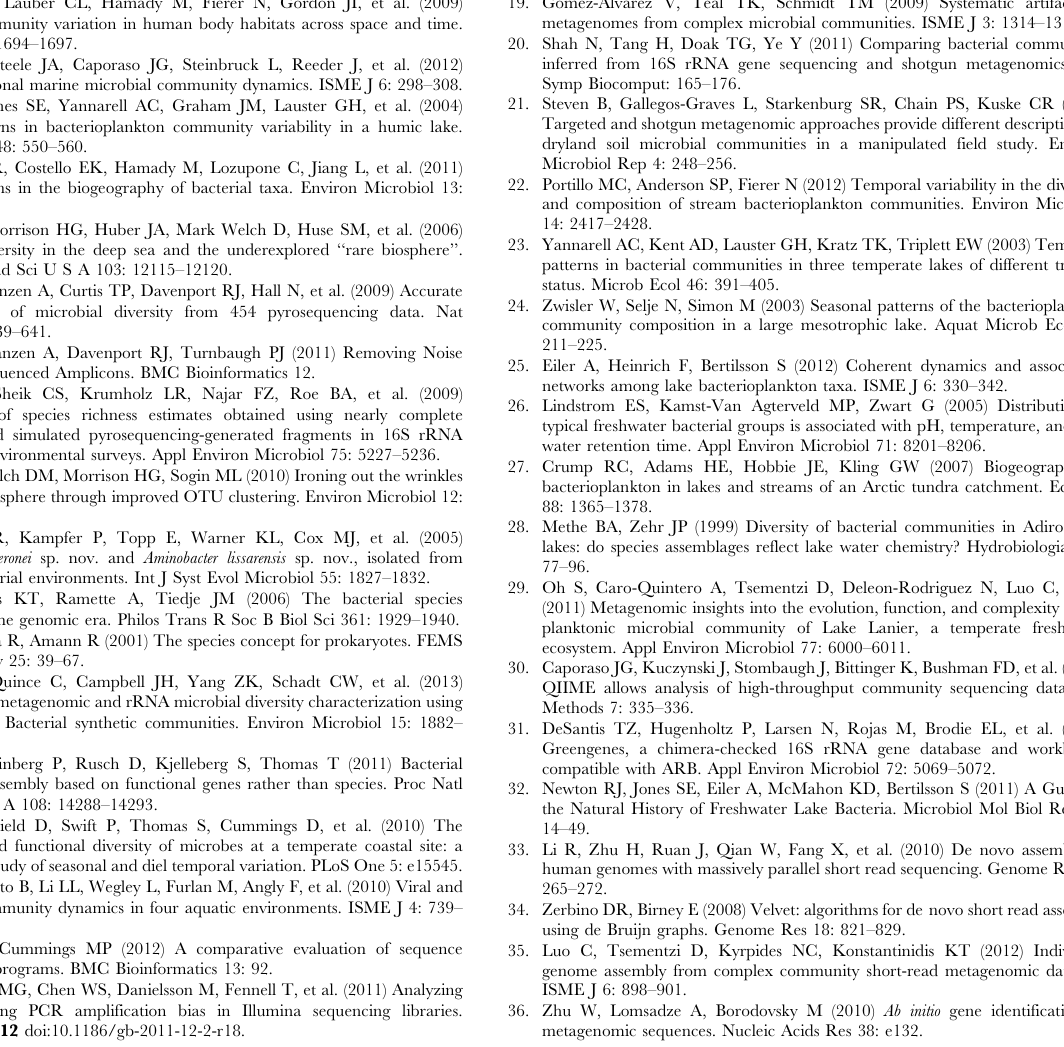
omes. Figure S5 Differences in abundance of individual genera based on 16S and metagenomes. Figure S6 Abundance of an individual Burkholderia -like population based on 16S amplicon vs. 16S metagenomic reads. Table S1 Characteristics of Lake Lanier at Brown’s Bridge for several dates in 2009. Table S2 V1, V3 specific primers used for amplification of the 16S rRNA gene. Table S3 16S rRNA gene amplicon library statistics. Table S4 metagenome library